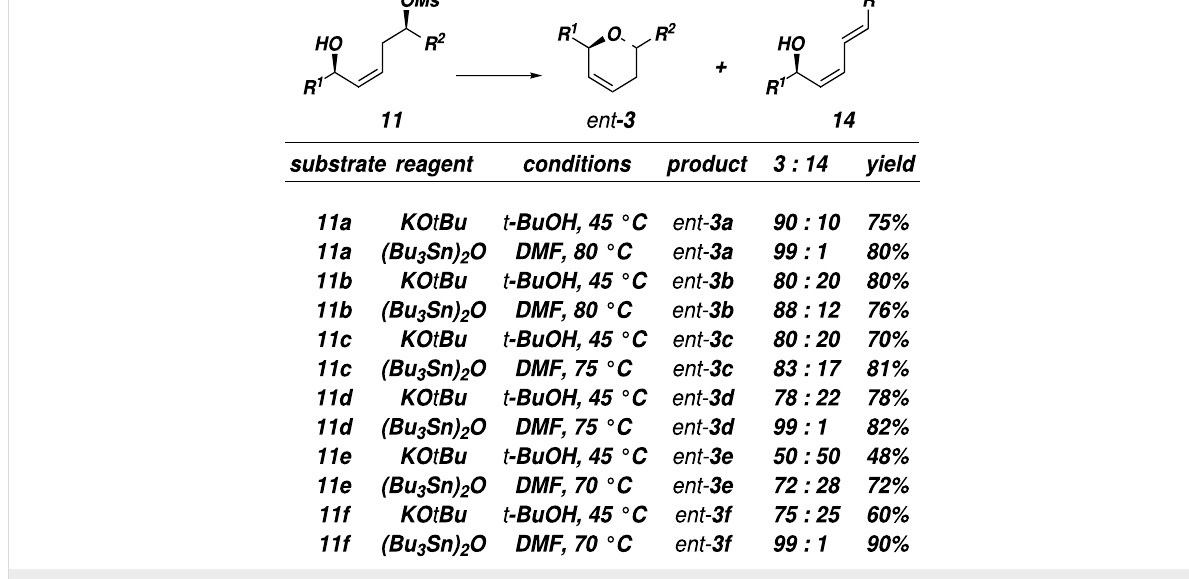
Figure 3: Cyclization of Hydroxymesylates 11